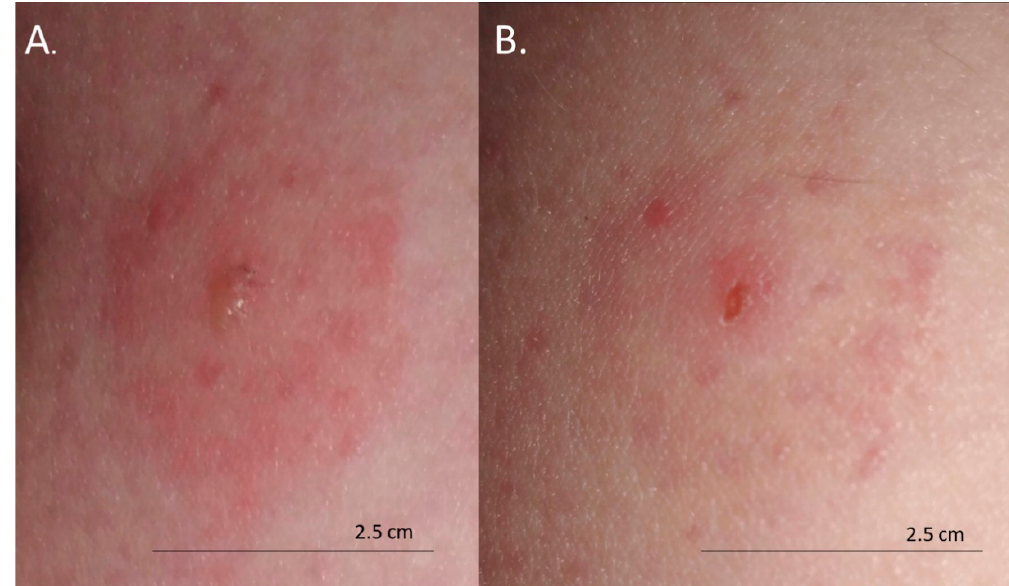
Figure 3. Bites from deer ked ( Lipoptena cervi ): ( A ) formation of vesicles on the skin 48 h after the bite; ( B ) small erosions 72 h after the bite.